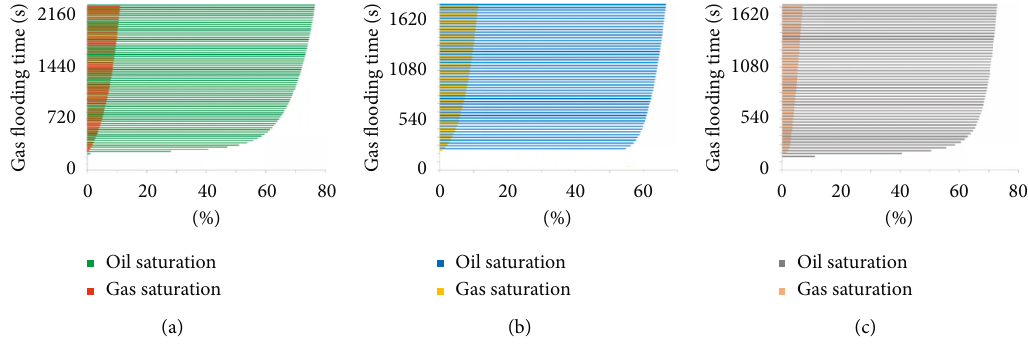
Figure 10: The relationship between TSD and gas saturation at diverse gas injection times. (a) Q � 100 μ L/min; (b) Q � 200 μ L/min; (c) Q � 300 μ L/min.